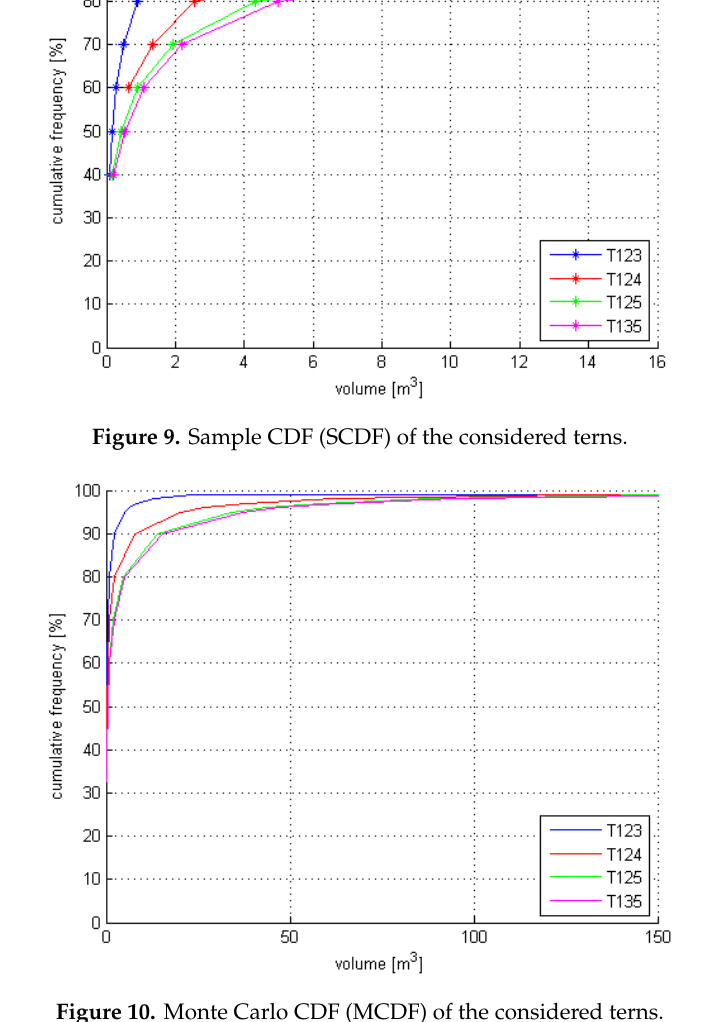
Table 7. Comparison of ratios between volumes calculated considering different mean spacing types. Tern